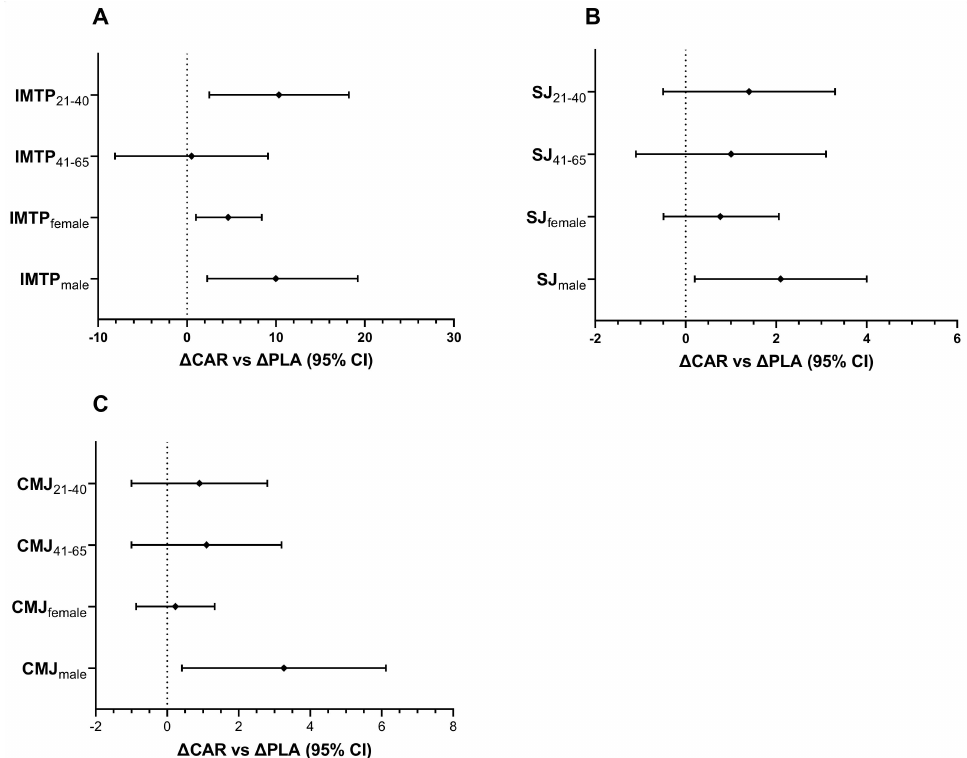
Figure 10. Performance metrics ∆ CAR vs. ∆ PLA (95% CI). The 95% confidence intervals of the between-group difference are shown for the relative change from Wk5-Pre to Wk5-Post ( ∆ CAR vs. ∆ PLA) by gender and age for IMTP ( A ), SJ ( B ), and CMJ ( C ). The groups are carnitine (CAR) and placebo (PLA). Abbreviations: IMTP = isometric mid-thigh pull; SJ = squat jump; CMJ = countermovement jump.